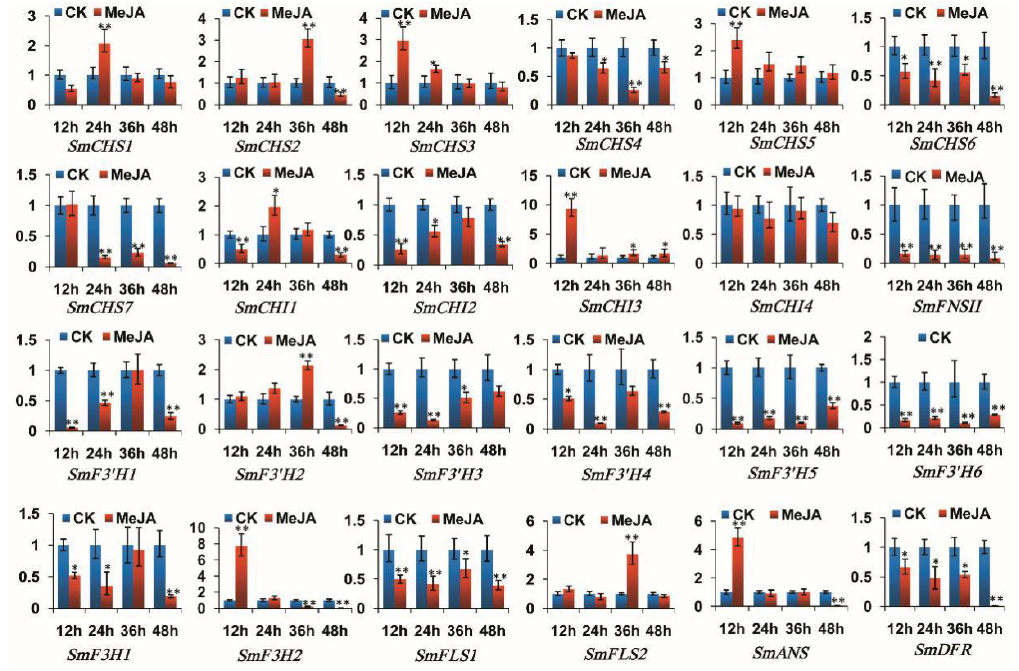
Figure 9. Expression of flavonoid biosynthesis-related genes in leaves of S. miltiorrhiza treated with MeJA for 12 h, 24 h, 36 h and 48 h. qRT-PCR method were used. p < 0.05 (*) and p < 0.01 (**) were considered statistically significant and extremely significant, respectively.